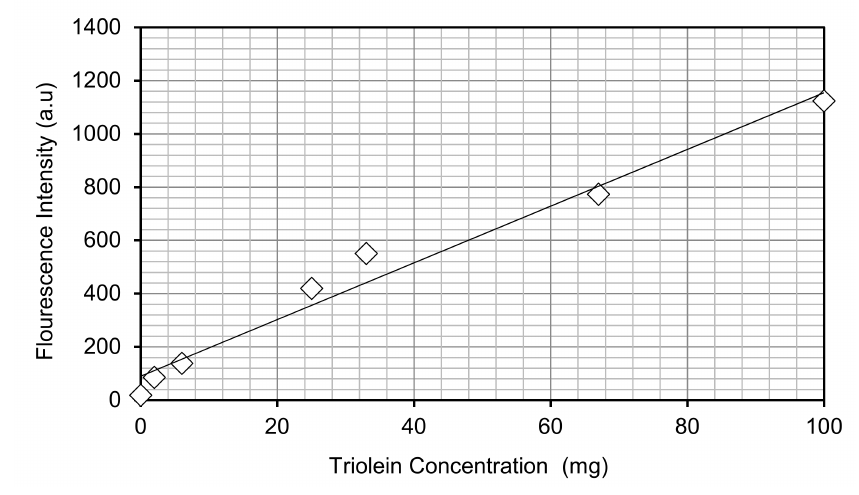
Figure A1. Relationship between triolein concentration and fluorescence